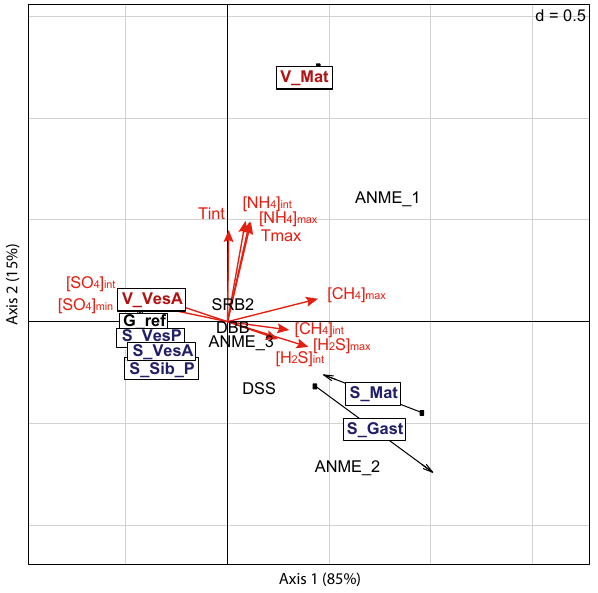
Figure 3. Co-inertia analysis of physicochemical factors in soft- sediment assemblages: temperature, methane (CH 4 ) , hydrogen sul- fide (H 2 S), sulfate (SO 4 ) , ammonium (NH 4 ) and relative abun- dances of microbial groups potentially involved in AOM: ANME1, ANME2, ANME3, DSS, DBB, SRB2. p = 0.01, axis 1 accounts for 85% of the variation and axis 2 represents